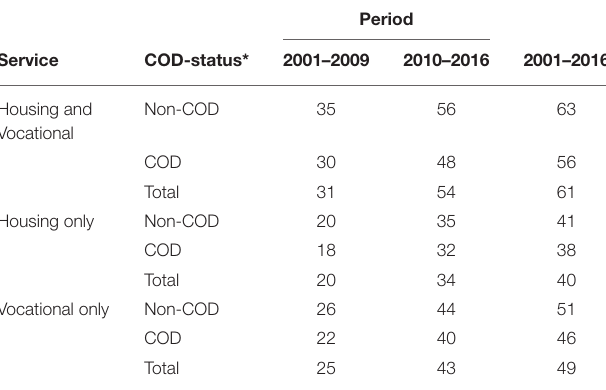
TABLE 2 | Percent of patients who received housing and/or vocational rehabilitation services by period (2001–2009, 2010–2016) and overall, and